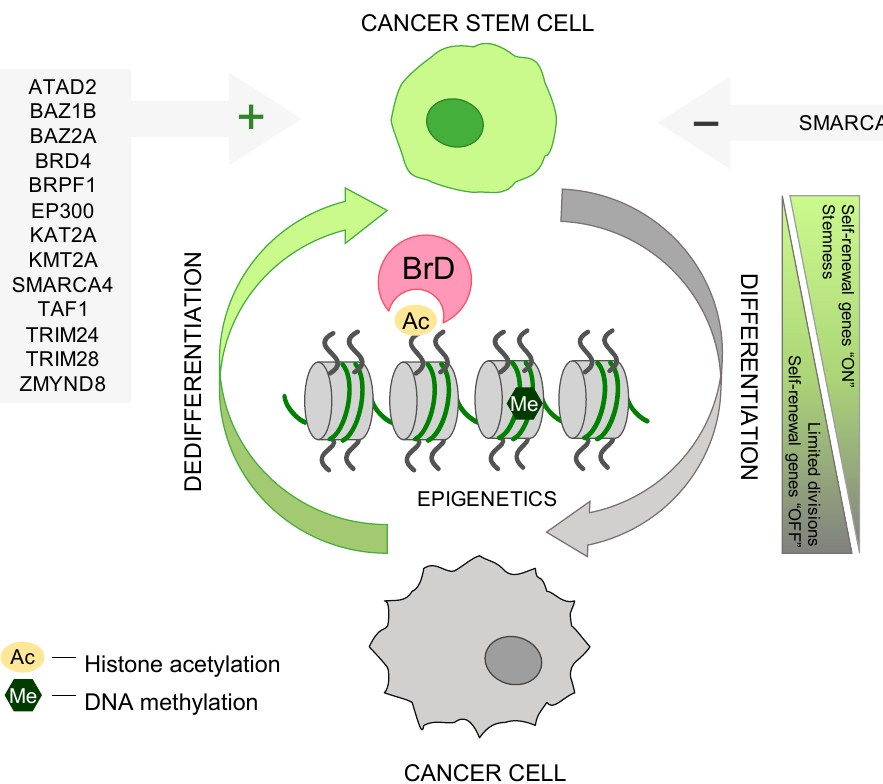
Figure 1. Bromodomain (BrD) proteins and their engagement in regulating the cancer stem cell-like phenotype of solid tumors. BrD module recognizes ε -N-lysine acetylation (Kac) motifs on histone proteins, enabling BrD proteins to mediate epigenetic regulation of gene expression. To date, several BrD members were confirmed mechanistically as positive regulators of cancer stemness, including ATAD2, BAZ1B, BAZ2A, BRD4, BRPF1, EP300, KAT2A, KMT2A, SMARCA4, TAF1, TRIM24, TRIM28, and ZMYND8. On the other hand, SMARCA2 was recognized as a negative regulator of cancer stemness.